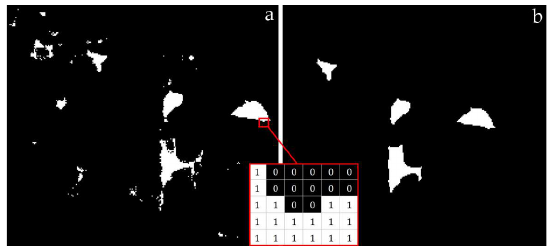
Figure 7. Example of Segmentation for downward displacements identification. (a) Binary image where the white pixels are those having Δh values greater than 13 mm. (b) Binary image after